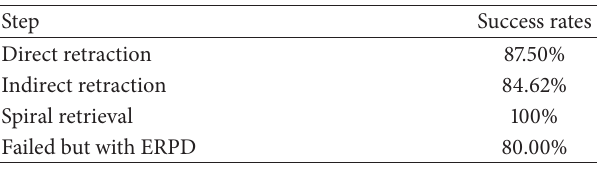
Table 2: Stent removal success rates in each